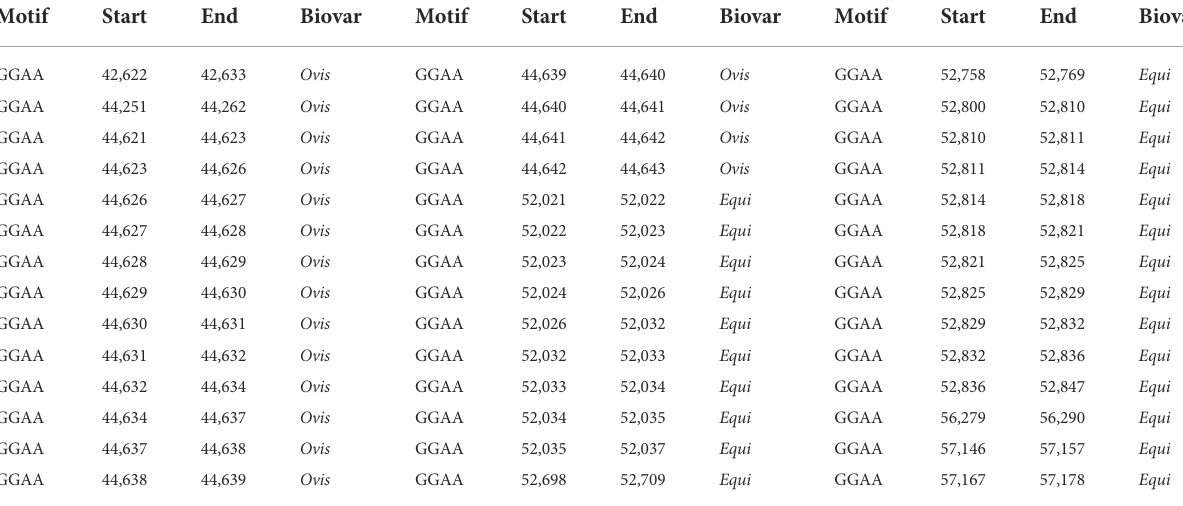
TABLE 2 Localization of the GGAA motif between equi and ovis biovars.